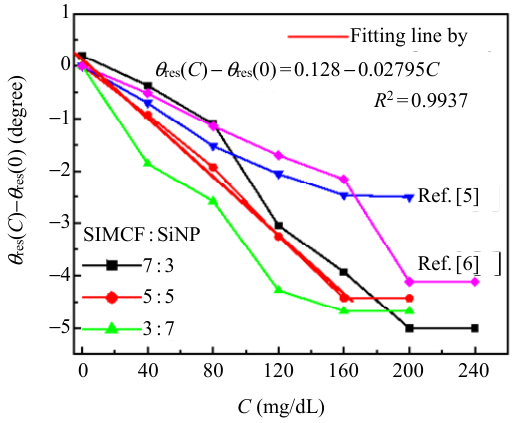
Fig. 7 Resonance angles of the GSMs with different component rates of SiMCFs and SiNPs: (a) 7 : 3, (b) 5 : 5, and (c) 3 :